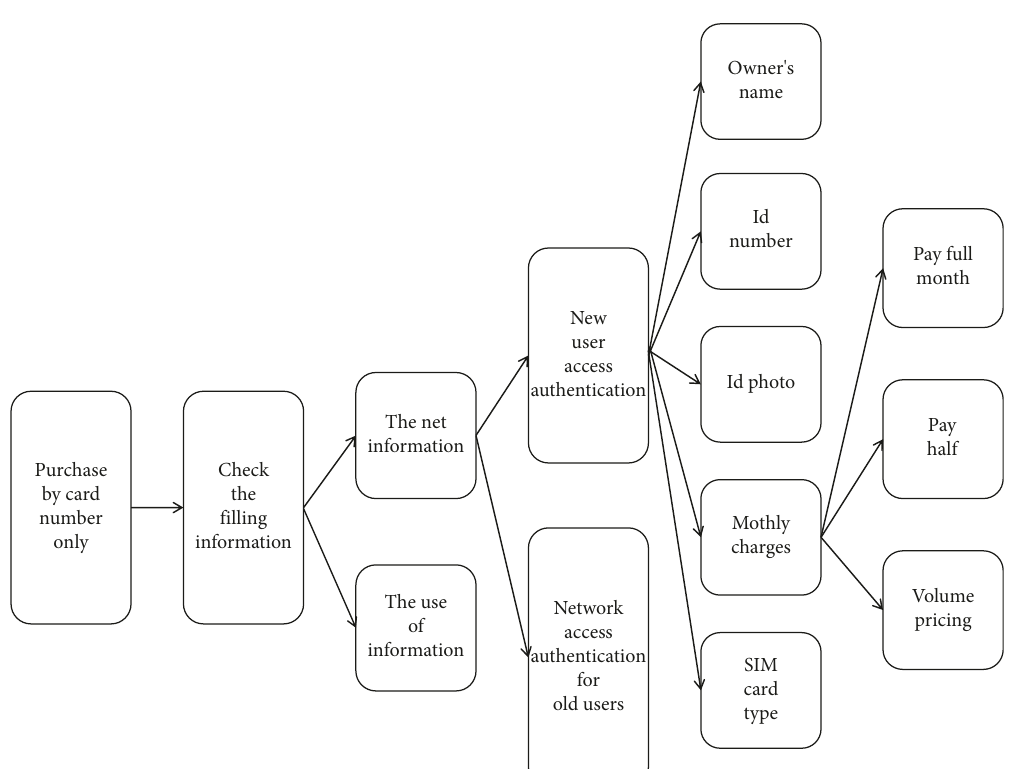
Figure 3: Analysis of network user behavior by data mining.